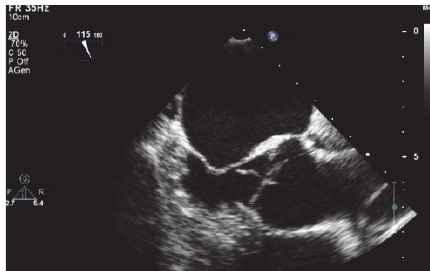
Figure 4: Transesophageal echocardiography. A linear structure arises from the line of closure of the aortic